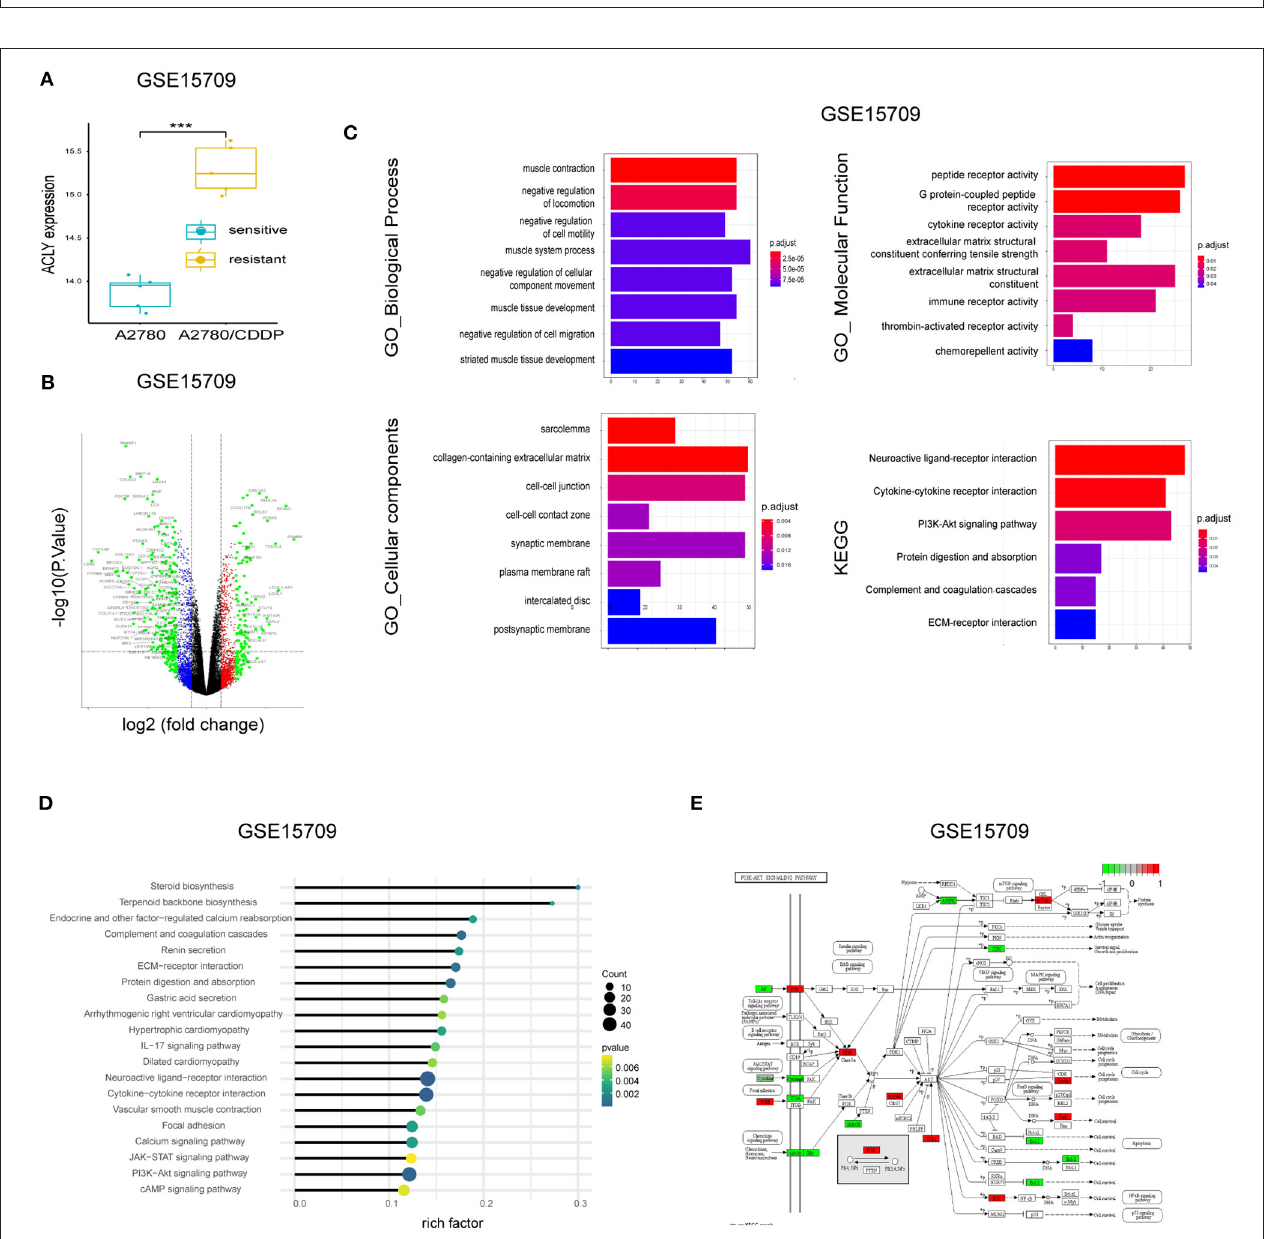
FIGURE 2 | (H) Tumor xenograft formation of A2780-shACLY and A2780-NC cells in nude mice, with each group containing five mice. The difference in volume, growth curves and weights were calculated and presented. The growth curves were analyzed using one-way ANOVA test. NC negative control. The difference of